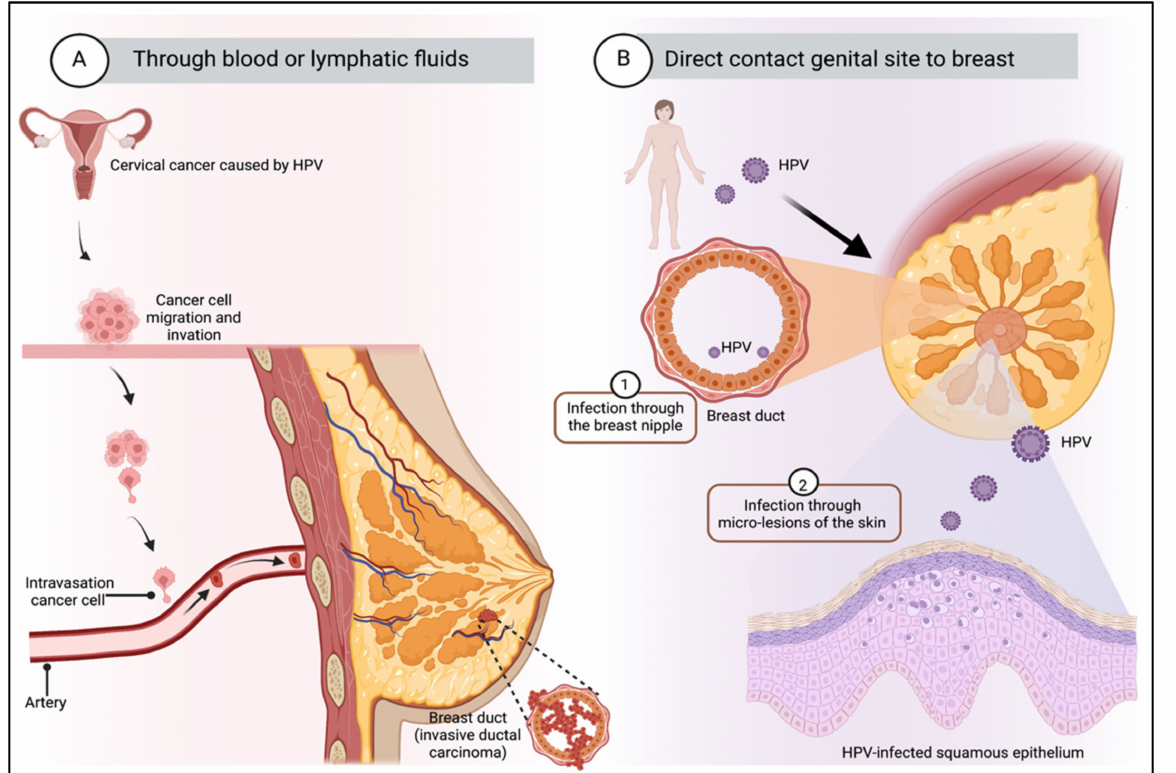
Figure 2. Transmission route of HPV to breast tissue. There are mainly two possible mechanisms: ( A ) Through the blood or lymphatic fluids from the primary site of infection. It is suggested that malignant transformation results from transfection of cells from a primary tumor by plasma flow or that HPV virions can be transported from the site of initial infection to other organs. ( B ) Through the skin of the nipple, by direct contact between the genitals and the breast. The mammary ducts are open ducts and could represent an entry point for virus infection. Transmission can occur through hand contact with the genitals and the mammary gland, which could happen during sexual activity, or through contact of bodily fluids with the fissures of the nipple, which can serve as an entry point for HPV. Created by